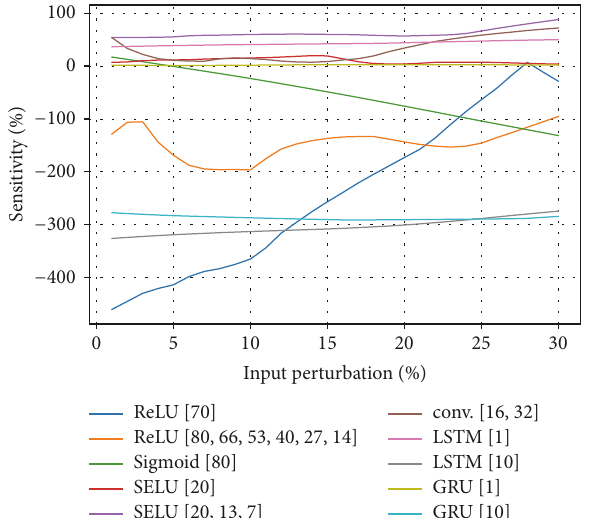
Figure 15: Trend in sensitivity for different disturbances in wind